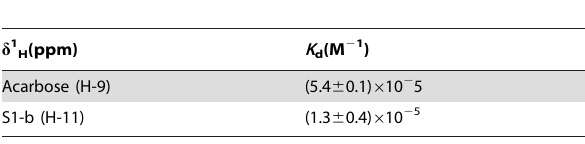
Table 4. Dissociation constant K d for acarbose/ntMGAM system and S1-b/ntMGAM system complex determined by relaxation